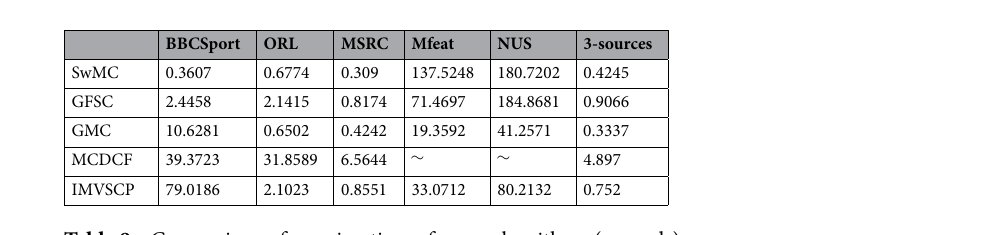
Fig. 6. It is proved that the convergence rate of algorithm 2 is fast enough to converge within 60 iterations. Table 9 shows the comparison of running time of some state-of-the-art algorithms on six datasets. As can be seen from Table 9, although the IMVSCP algorithm first generates the similarity matrix of each view dynamically and iteratively, and then the spectral clustering algorithm is combined with the symmetric nonnegative matrix fac- torization algorithm to generate clustering results, the running time of IMVSCP is not longer than other state- of-the-art algorithms on the whole.